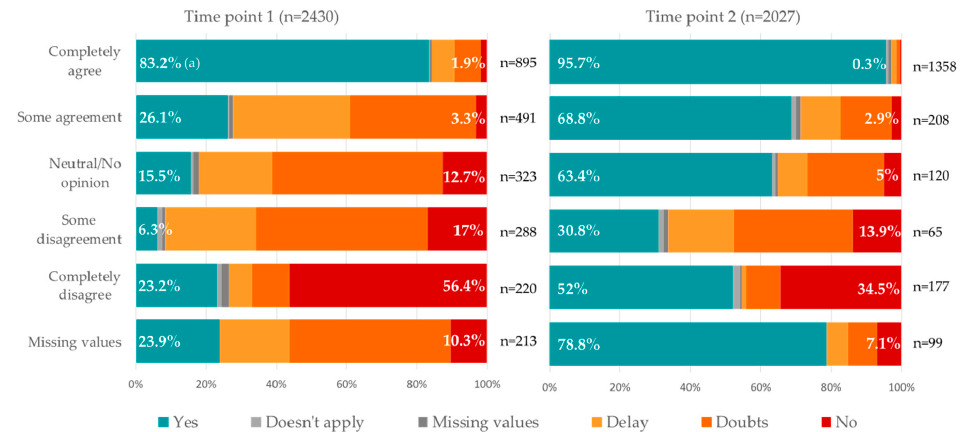
Figure 1. From intention to practice: Comparison between the agreement to accept an approved and recommended vaccine (Lazarus, ref. [11]) versus the actual intention to vaccinate (TP1) or already been vaccinated (TP2) (Picchio, ref. [6]); in Barcelona’s nurses, by submission time. COVID-19 Vaccine Hesitancy Study. Barcelona. 2020–2021. Percentage value at the left (green bar) belongs to “yes, they will get vaccinated/they have been vaccinated” answers, and values in the right (red bar) to “no, they won’t get vaccinated” answers. For values to “delay” and “doubts”, please refer to Supplementary data.